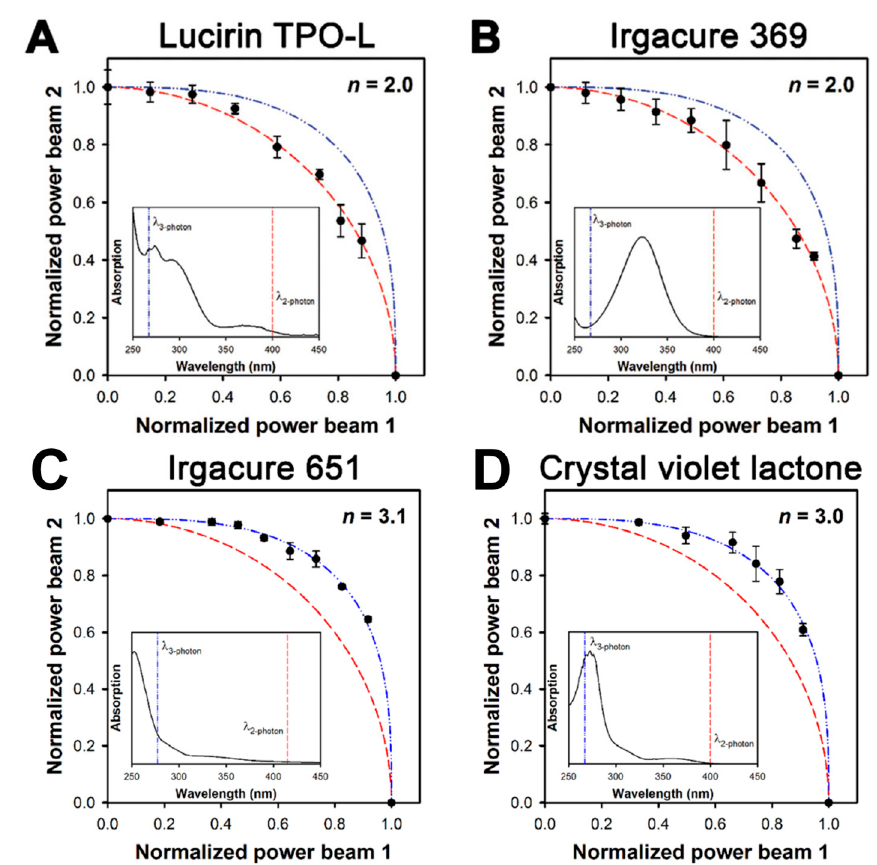
Figure 3. The graphs above show the results of a two-beam initiation threshold (2-BIT) measurement performed on an acrylic monomer resin containing one of the four photoinitiators; ( A ) Lucirin TPO-L; ( B ) Iragcure 369; ( C ) Iragcure 651; and ( D ) crystal violet lactone. The dashed red- and blue-lines correspond to values of n = 2 and n = 3, respectively. The insets show the UV-vis absorption spectra and the wavelength equivalent of two- or three- photon absorption by the 800 nm excitation laser. Reproduced from [23].